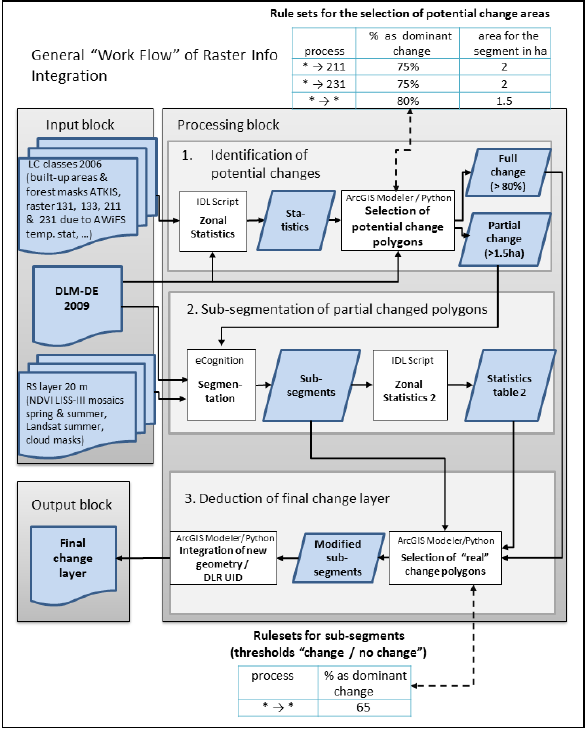
Figure 3: Work flow during the integration of satellite imagery, thematic raster layers and the input data of DLM-DE 2009 vector